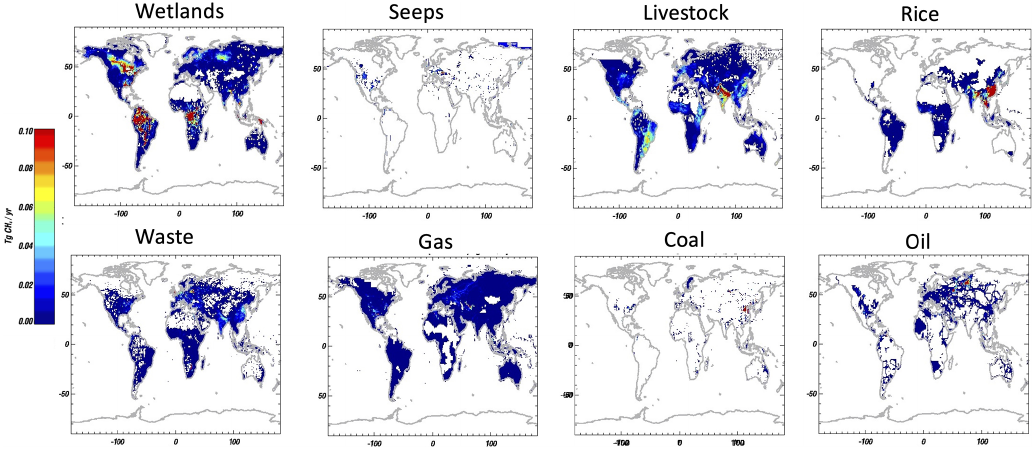
Figure 3. The square root of the diagonal of the a priori covariance for the eight largest sectors used in our analysis.